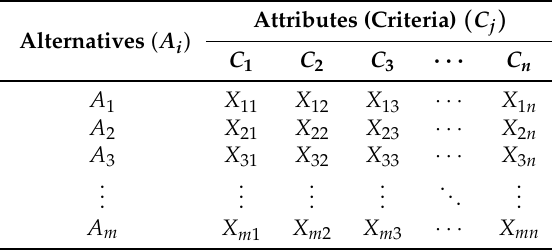
Table 1. Decision matrix for Multi-Attribute Decision Making (MADM)